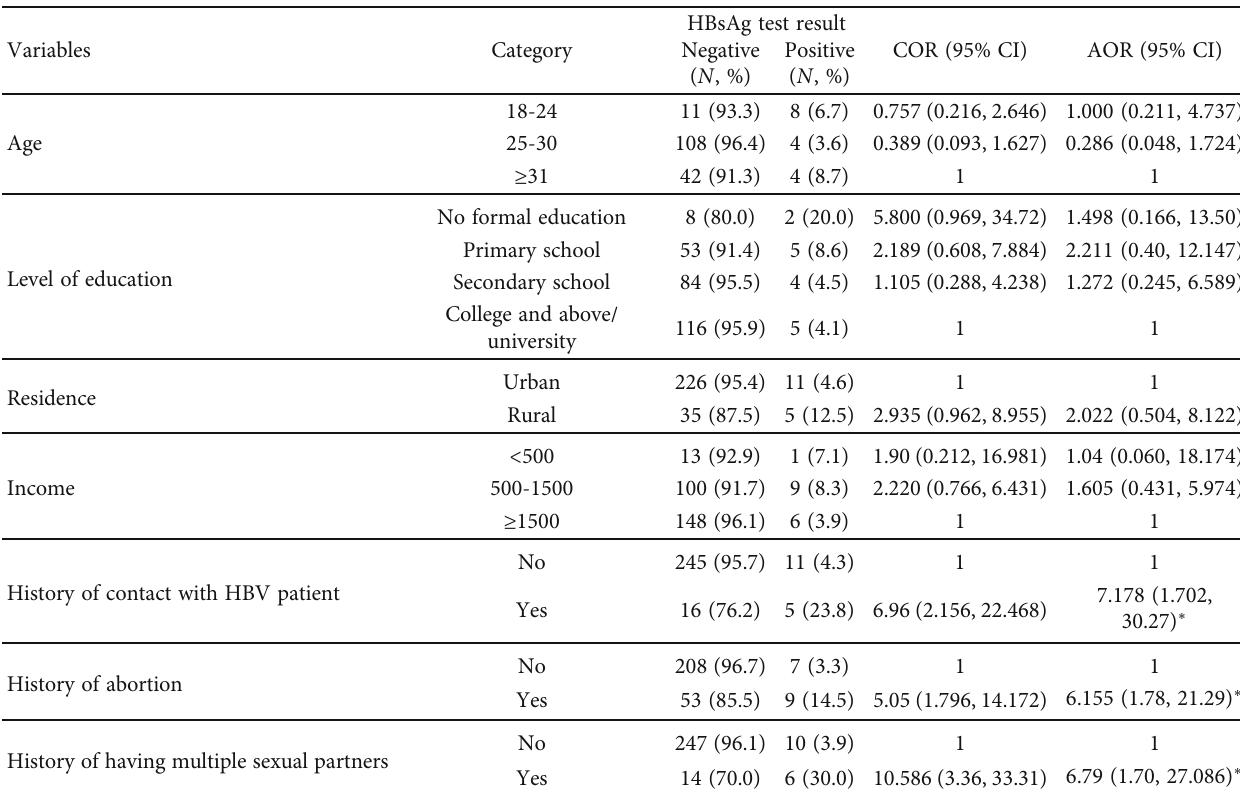
Table 4: Multivariable logistic regression analysis of seroprevalence of HBV infection and associated factors among pregnant women attending ANC at public health facilities in Nekemte town, Western Ethiopia,